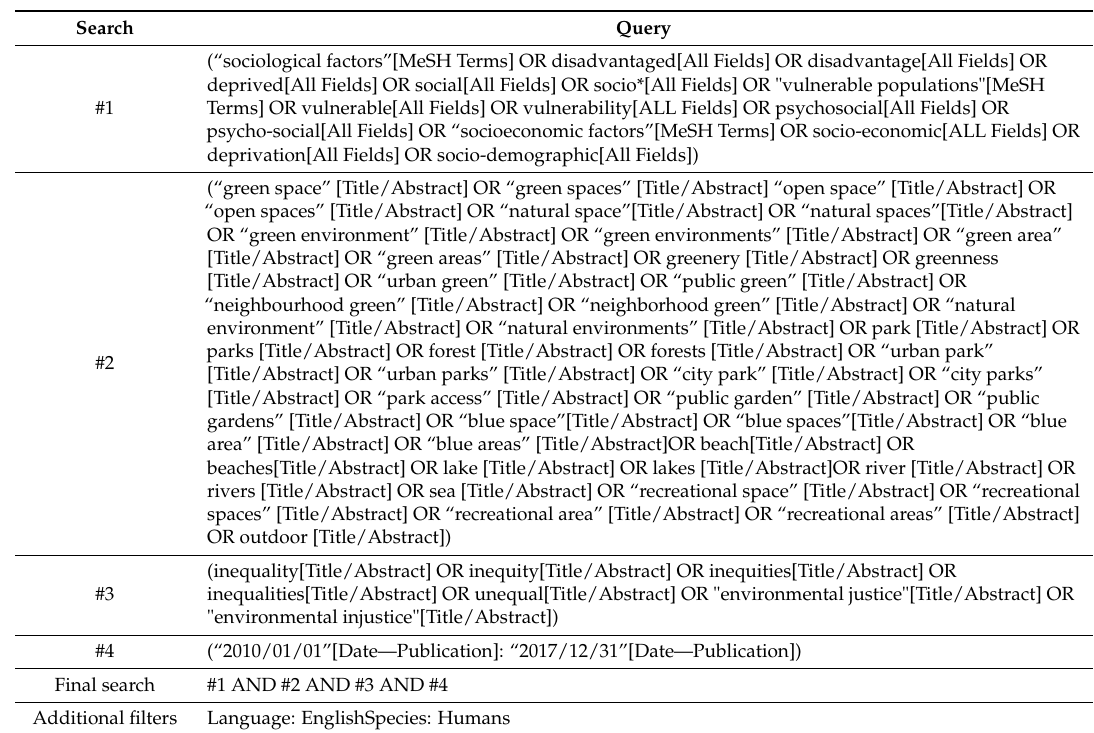
Table 1. Search terms and Medical Subject Headings in